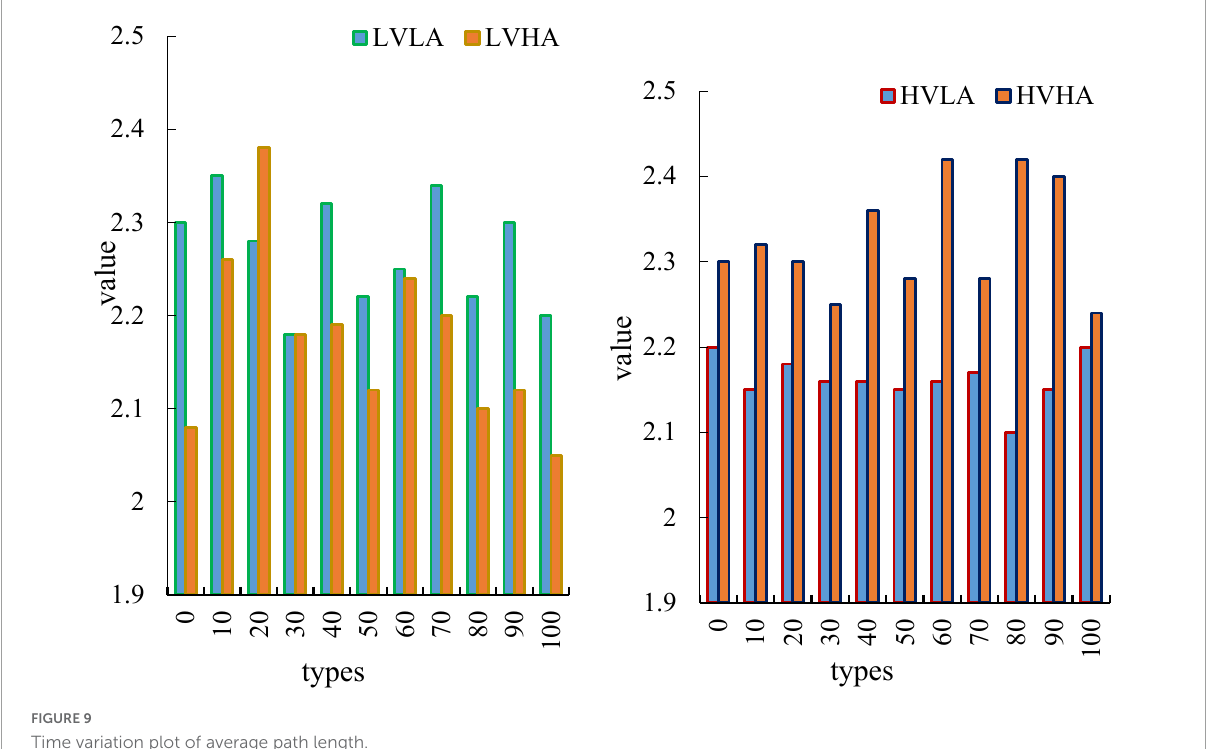
FIGURE9 Time variation plot of average path length.